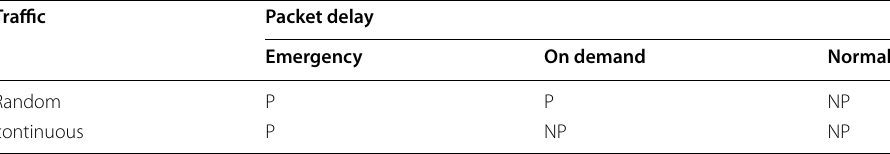
Table 2 Fuzzy rules base